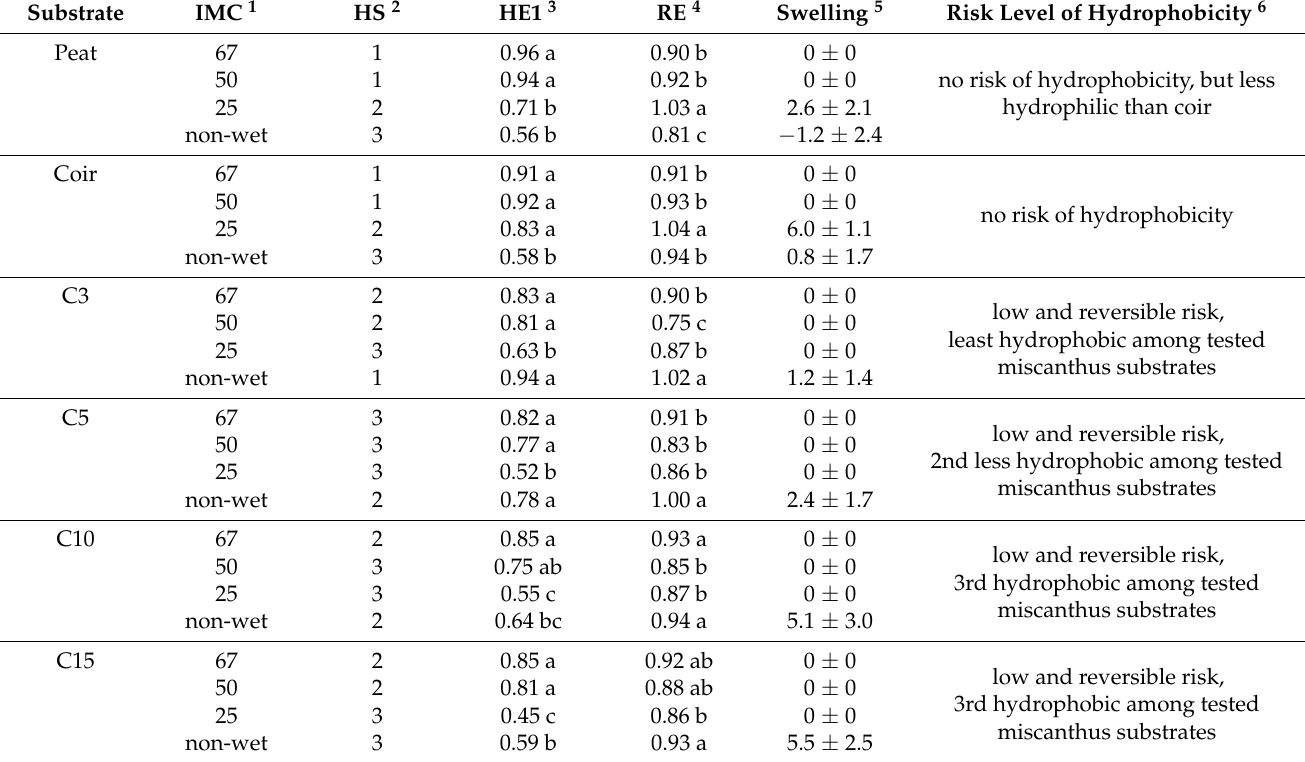
Table 6. Hydration efficiency of peat, coir, and processed miscanthus substrates.